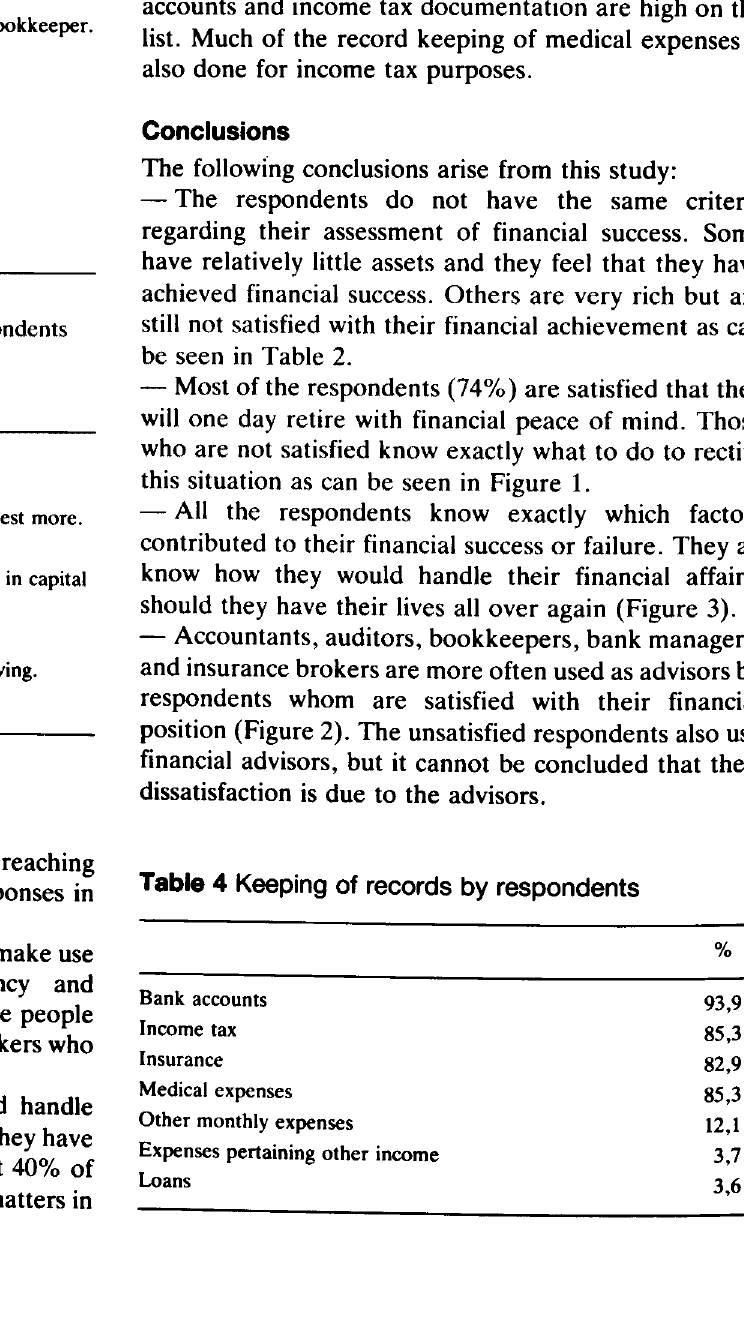
Figure 2 Financial advisors used by successful